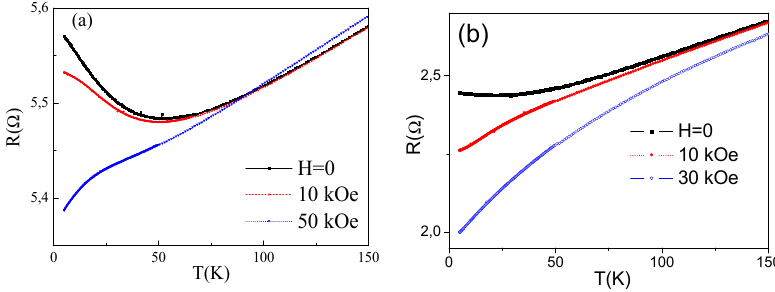
Figure 24. Effect of the magnetic field on temperature dependence of resistance, R, in as-prepared ( a ) and annealed ( b ) Cu 90 Co 10 microwires.